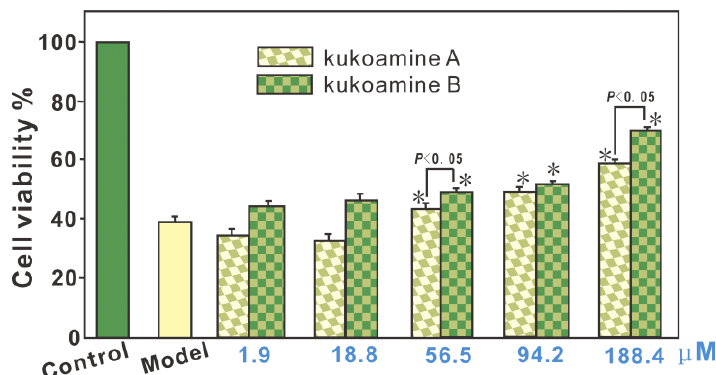
Figure 2. Protective effects of kukoamine A and B against Fenton-induced damage in bmMSCs, as measured in the MTT assay. These data represent the mean ± SD ( n = 5). * p < 0.05 vs. model. The Fenton reagent (FeCl 2 plus H 2 O 2 ) was used to generate •OH radicals. MTT, 3-(-dimethylthiazol-2-yl)- 2,5-diphenyltetrazolium bromide.